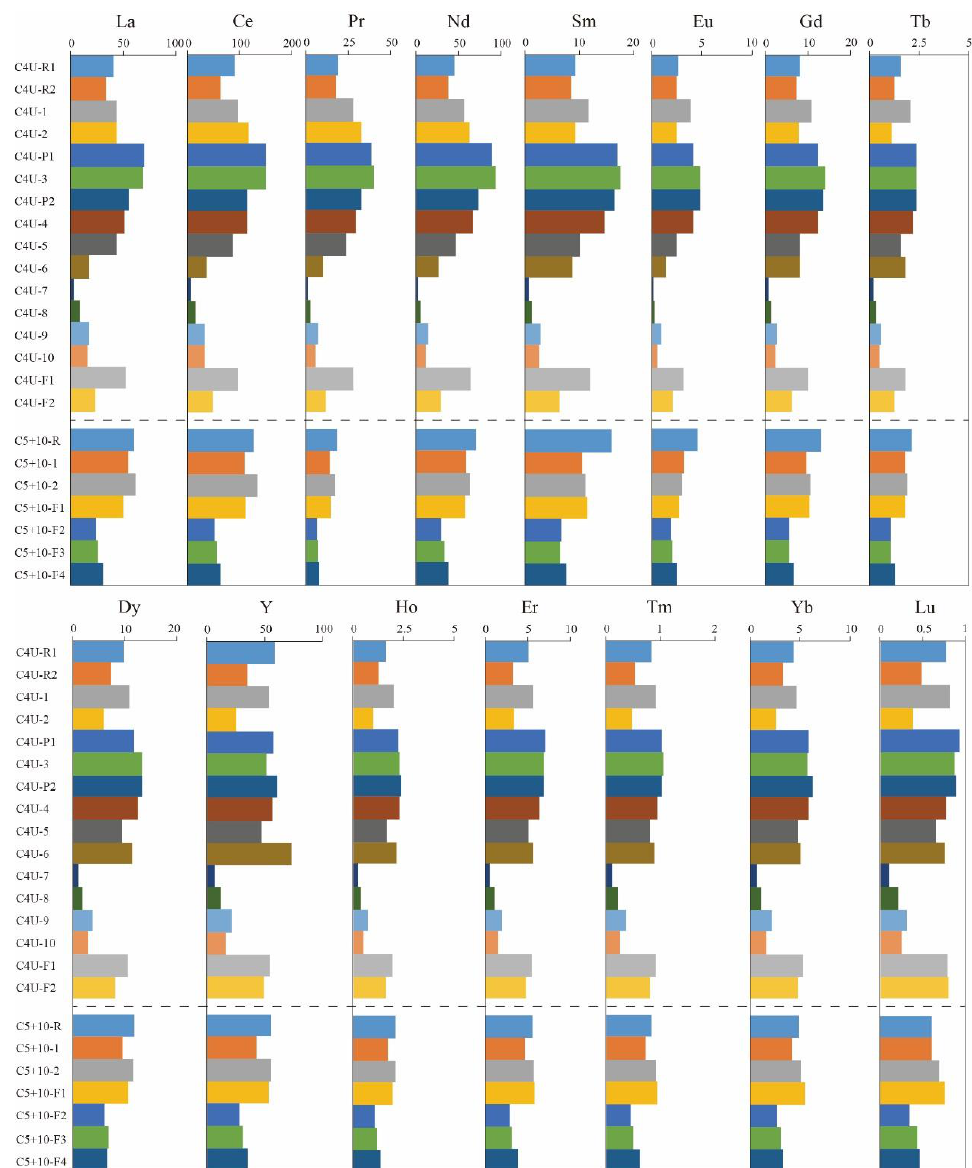
Figure 7. Vertical changes in contents of rare earth elements of the two coal seams. Note: Above the dashed line these samples are from the C4-Upper coal seam. Under the dashed line these samples are from C5 + 10 coal samples. All the elements are coal-basic, and the unit of abscissa is µg/g.